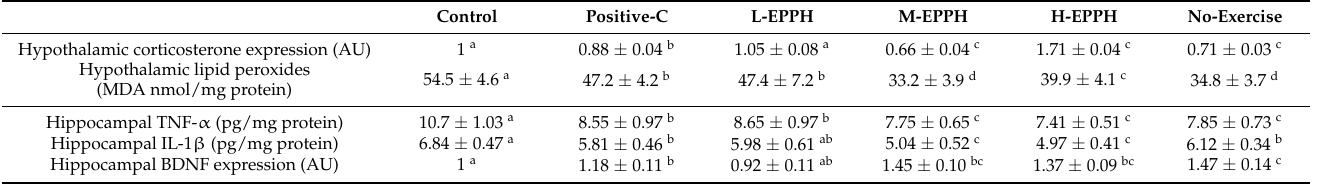
Table 5. Metabolic parameters related to exercise-induced fatigue in the brain after the 6-week intervention. Control Positive-C L-EPPH M-EPPH H-EPPH